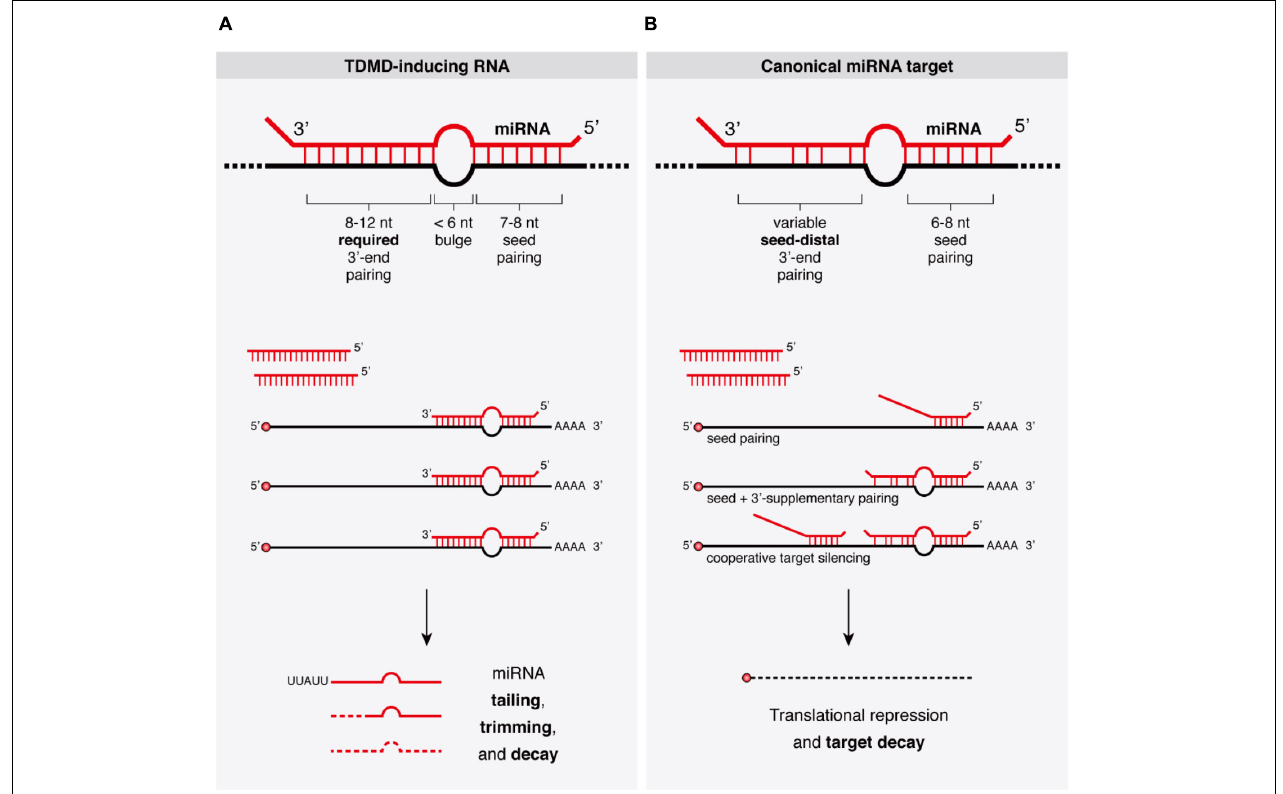
FIGURE 1 | Target binding architectures define the outcomes of miRNA binding. (A) Properties of TDMD-inducing target RNAs bound to their cognate miRNAs and concomitant miRNA tailing and trimming species accumulating during TDMD are schematically represented. Substoichiometric target RNA concentrations may suffice to trigger TDMD, allowing miRNAs to induce only limited or no target degradation. (B) Properties of canonical miRNA targets typically leading to target RNA silencing upon miRNA binding. Additional architectures such as ‘centered’ or ‘seedless’ interactions have been omitted, though the latter has been linked to TDMD (see text and Figure 2B